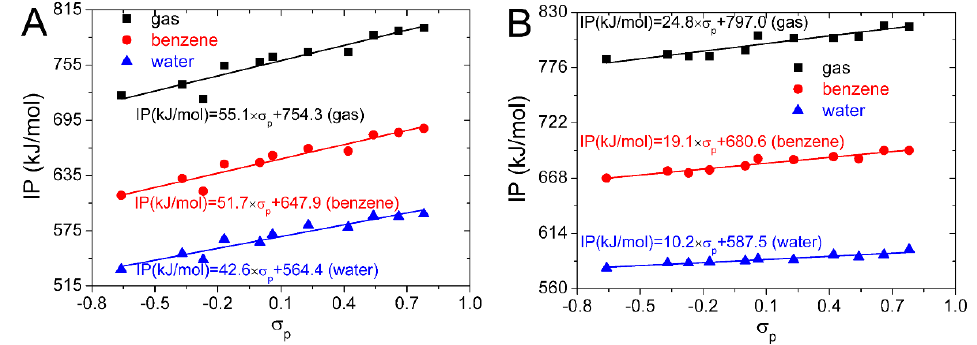
Figure 4. Dependence of IP on Hammett sigma constants for 4′,5,7 -trihydroxyisoflavone ( A ) and 4′,5,7 -trihydroxyisoflavanone ( B ) in gas, benzene, and water phases.